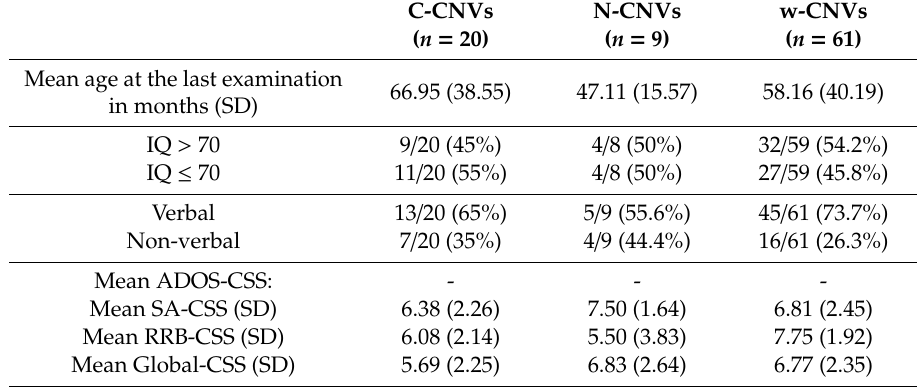
Table 4. Demographic features of participants grouped according to CMA results. For each group (with causative and non-causative CNVs, or without CNVs) are reported the mean age at the last examination (in months), the rate of patients with a IQ level > 70 vs. ≤ 70, the rate of verbal vs. non-verbal patients, and the mean calibrated severity scores (CSS) of the global Autism Diagnostic Observation Schedule (ADOS) scores and the sub-scores of the Social A ff ect (SA) and Restricted and Repetitive Behaviors (RRB) domains. The language level was assessed in all 90 participants, the IQ level and the ADOS scores were available for 87 and 67 of the 90 individuals, respectively. C-CNVs N-CNVs w-CNVs ( n = 20) ( n = 9) ( n = 61) Mean age at the last examination 66.95 (38.55) 47.11 in months (SD)